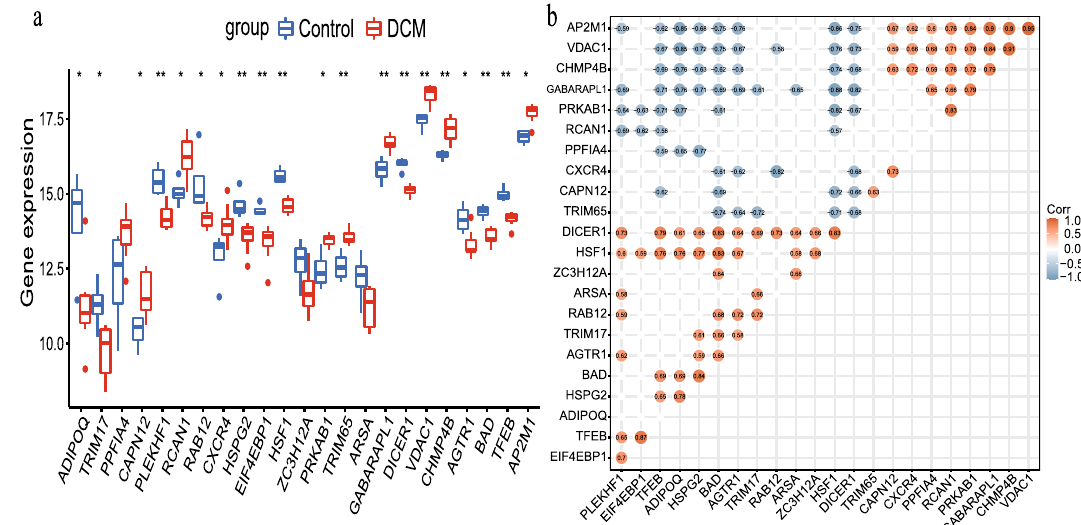
Figure 4. 23 AR-DEGs in dilated cardiomyopathy (DCM) group and control group and their correlation. ( a ) Box plot of the expression levels of 23 DEGs-Down in the DCM and control groups. The blue box plots above the corresponding gene names indicated expression in control groups, whereas the red box plots indicated expression in DCM groups. ( b ) Correlation heatmap of 23 AR-DEGs. The color within the circle shape and the magnitude of the correlation value represented the strength of the correlation; red represented positive correlation and blue represented negative correlation. The darker the color, the larger the absolute value of the correlation value represented a stronger